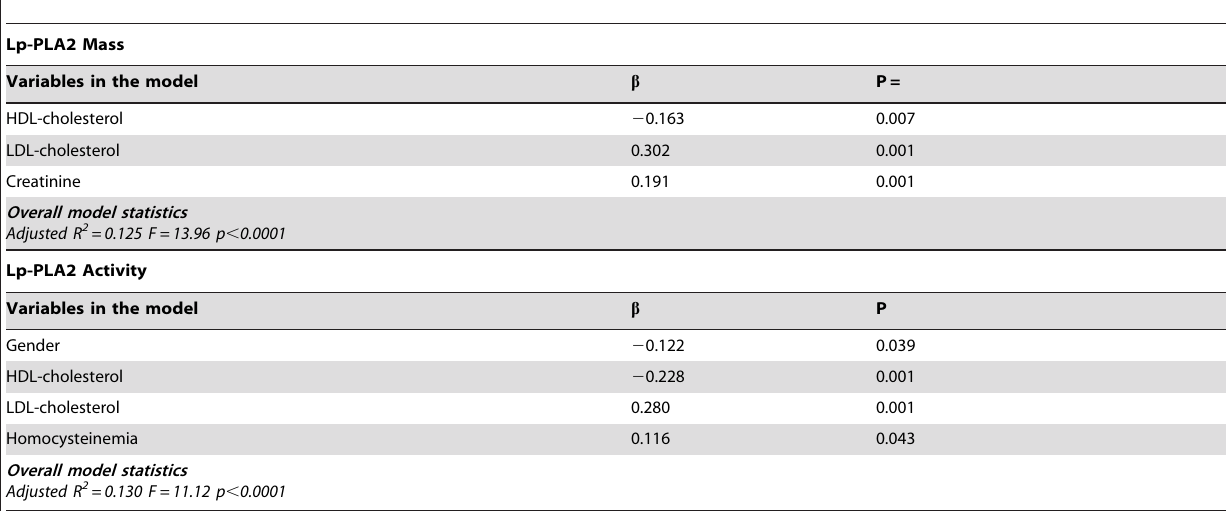
were observed. The CV death and event rate according to the Lp- p = 0.012, respectively), CV events (p = 0.016 for Lp-PLA2 PLA2 mass and activity quartiles (Fig. 2 and 3, respectively) activity), and AMI (p = 0. 019 for Lp-PLA2 activity), but not for evidenced a stepwise increase of CV deaths (p =0.020 and strokes, for either variable. However, it has to be noted that only Table 3. Stepwise linear regression analysis of determinants of Lp-PLA2 mass and